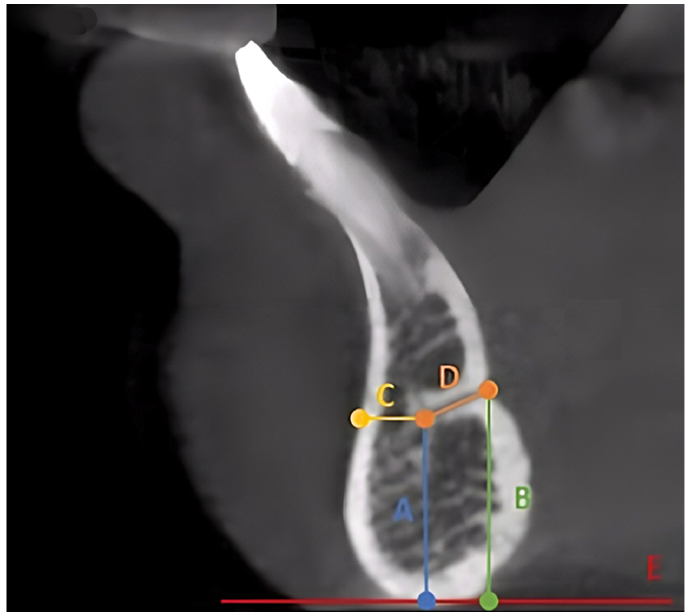
Figure 2. CBCT sagittal cut photograph showing study variable measurements: ( A ) Inferior border to the buccal terminal; ( B ) inferior border to the lingual terminal; ( C ) buccal cortex to the buccal terminal; ( D ) canal length; ( E ) lower border reference line.